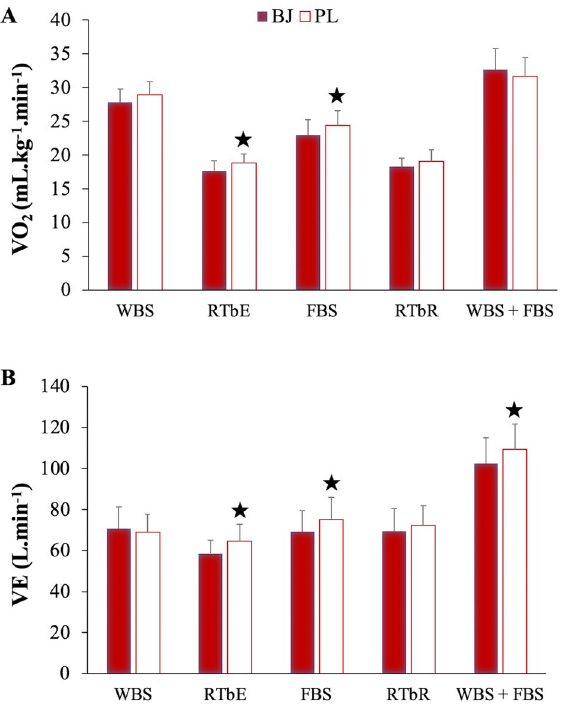
Figure 5. Oxygen uptake ( A ) and ventilation ( B ) after beetroot juice and placebo intake. Data are provided as mean and error bars as 95% confidence intervals. BJ, beetroot juice; FBS, full back squat; PL, placebo; RTbE, rest time between exercises; RTbR, rest time between routines; VE, minute ventilation; VO 2 , oxygen uptake; WBS, wall ball shots. ★ A significant increase in the VO 2 and VE after PL compared to BJ intake (p <